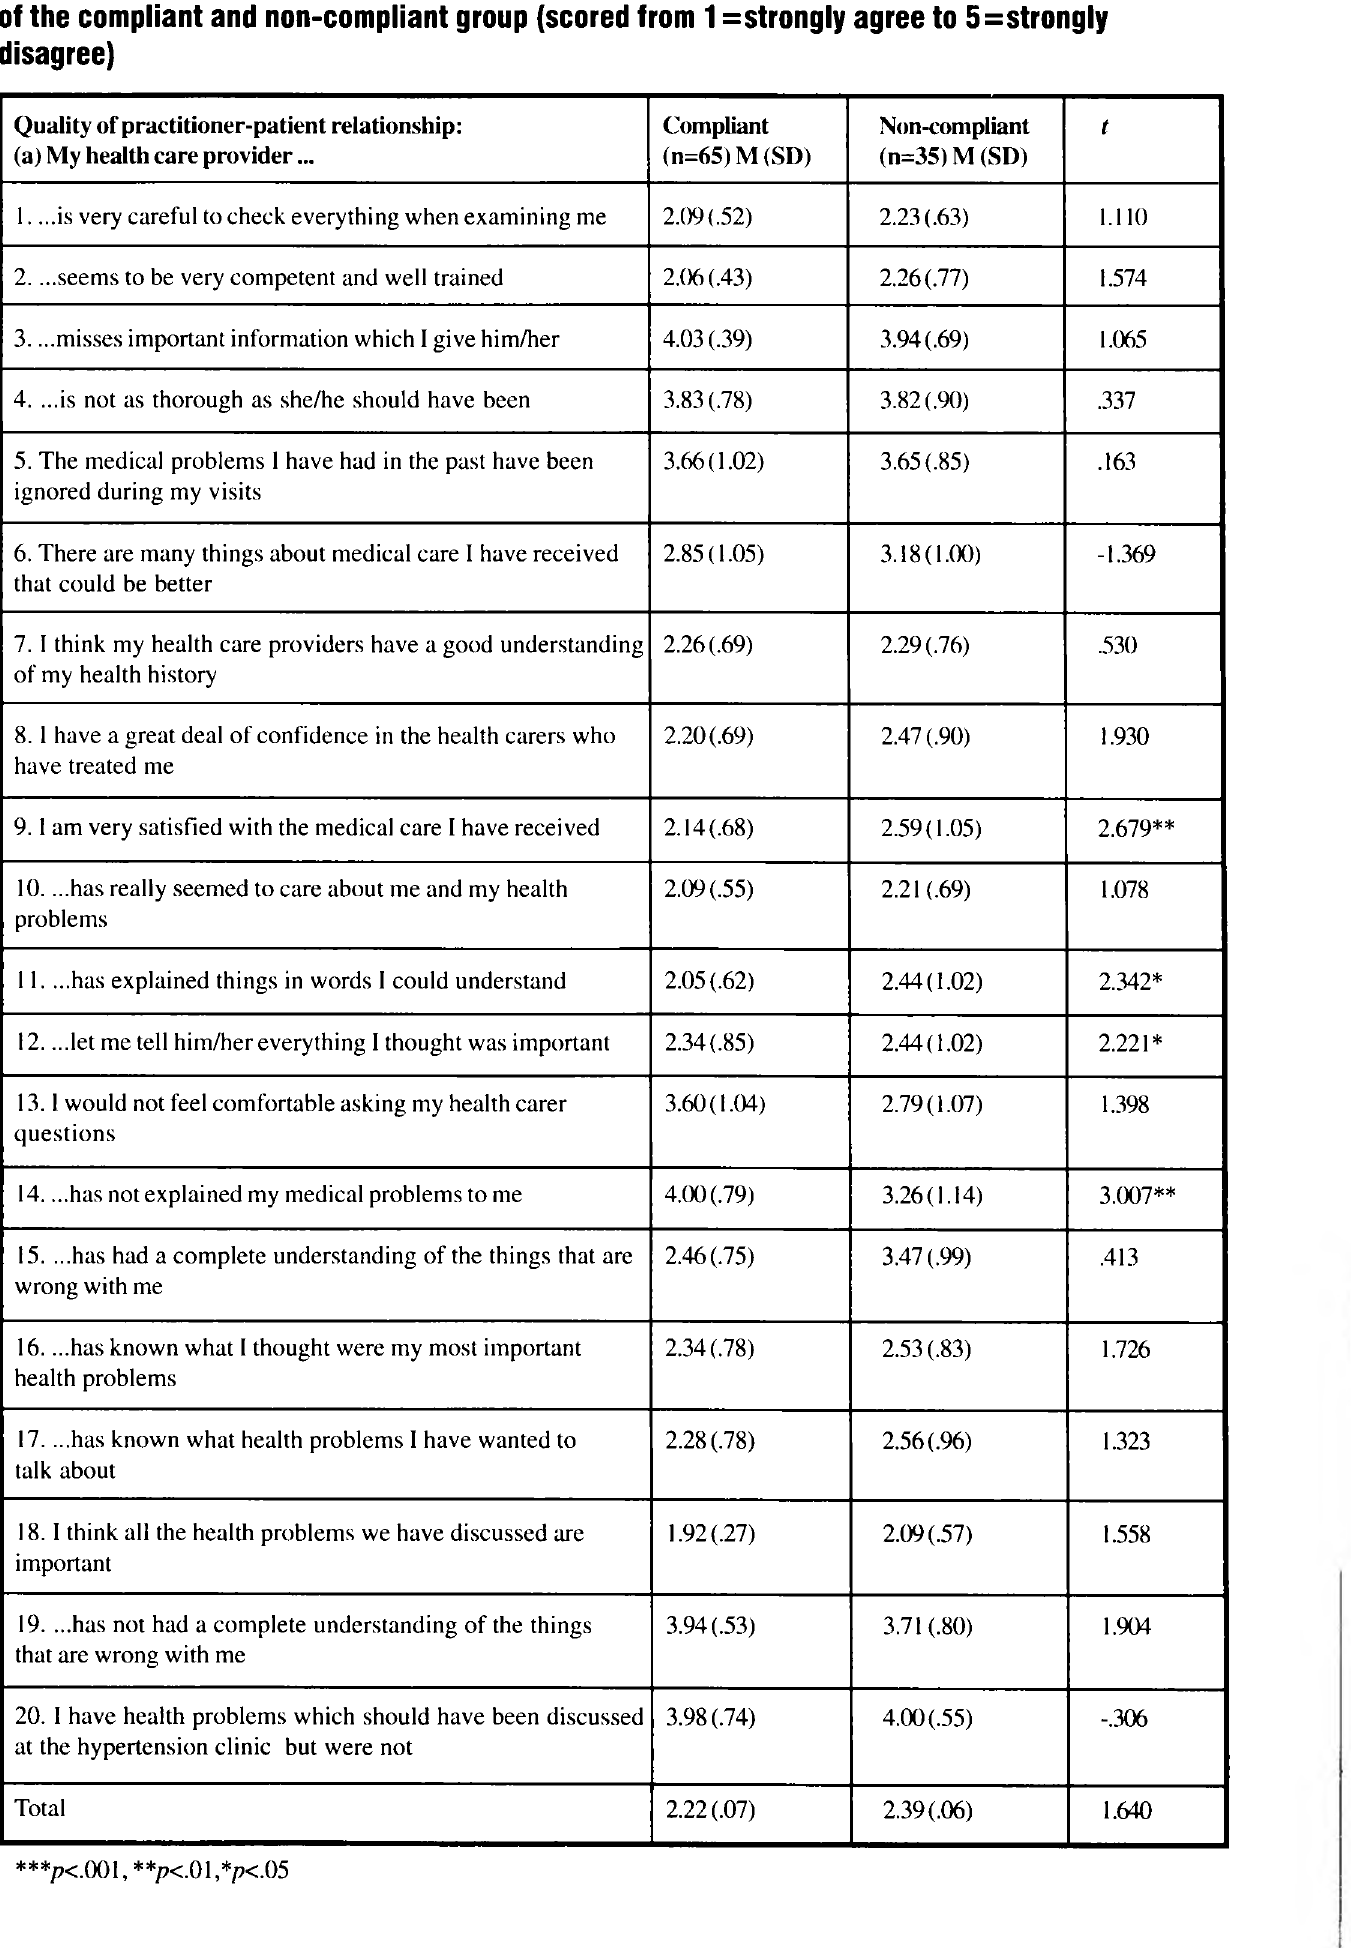
Table 5: Means, standard deviations and t- test for the quality of practitioner-patient relationship of the compliant and non-compliant group (scored from 1 =strongly agree to 5=strongly disagree) Quality of practitioner-patient